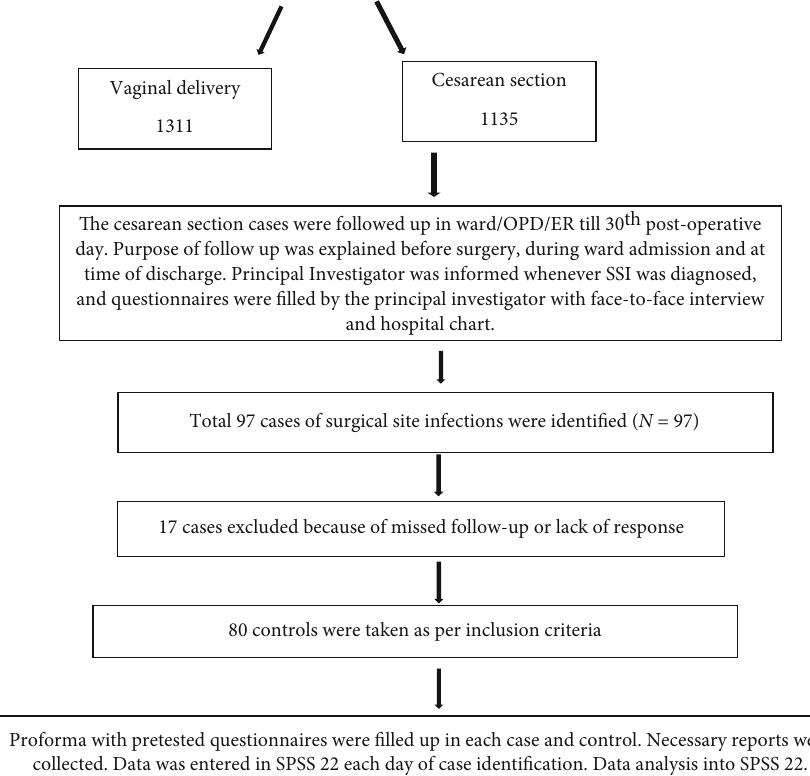
Figure 1: Study design/framework.